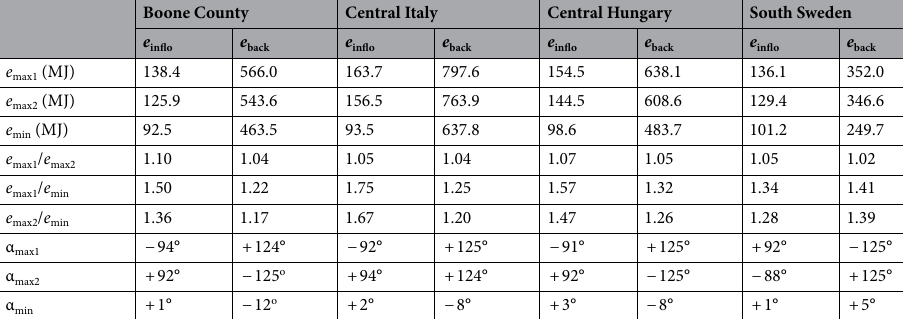
Table 2. Total energies per unit area e inflo and e back absorbed by the inflorescence and the back of a mature sunflower head between anthesis (1 July) and senescence (7 September) in Boone County, central Italy, central Hungary, and south Sweden. e max1 : primary maximum, e max2 : secondary maximum, e min : minimum, α max1 : azimuth angle of